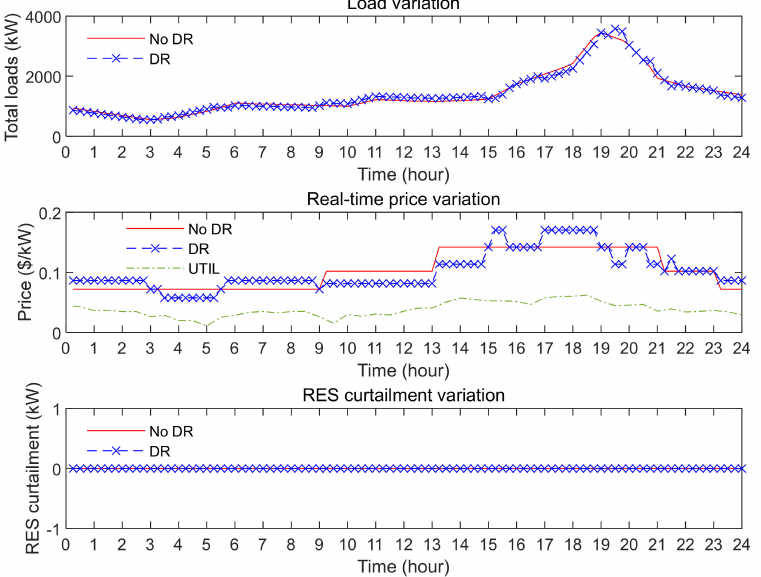
Figure 10. Variations of load demand, real-time prices, and RES curtailment for load type A (the distribution operator is able to sell electricity to the utility grid).